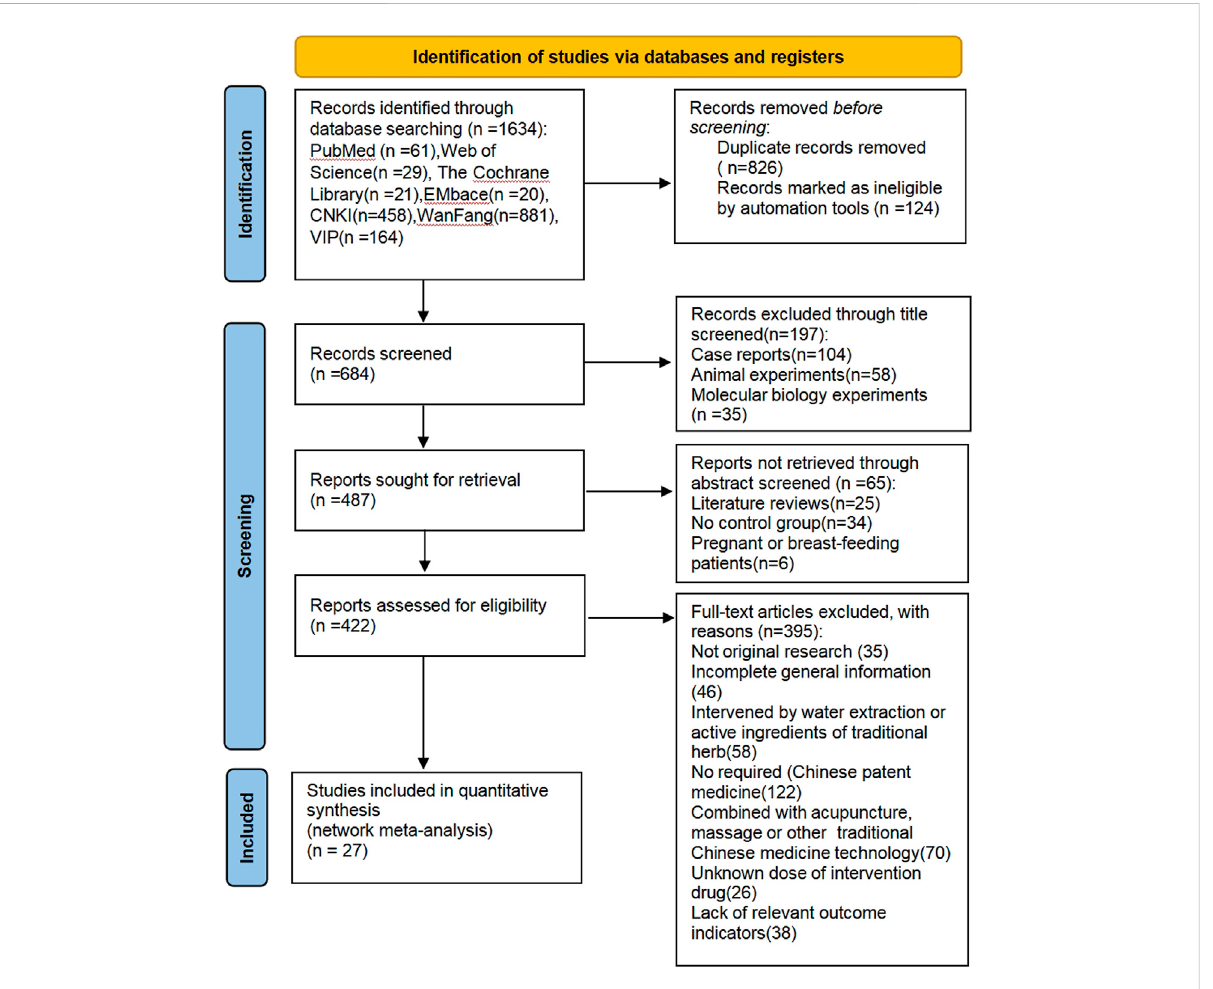
FIGURE 1 Study selection